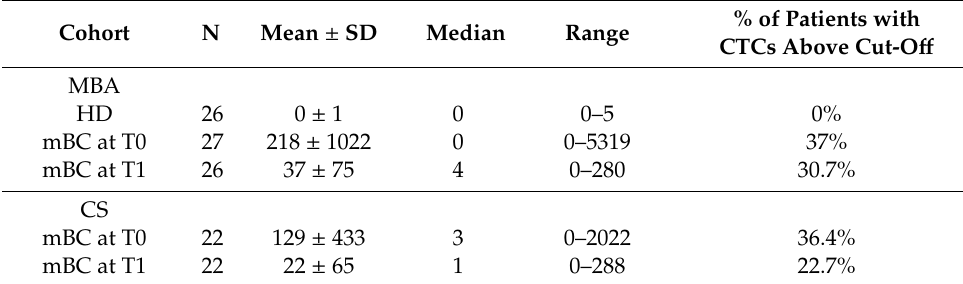
Table 2. Prevalence of CTCs at baseline (T0) and follow-up (T1) as detected by the metabolism-based assay (MBA) and CellSearch (CS), according to the cut-o ff of 6 and 5 CTCs, respectively. (HD = healthy donor volunteers; mBC = metastatic breast cancer patients). N Mean ± SD